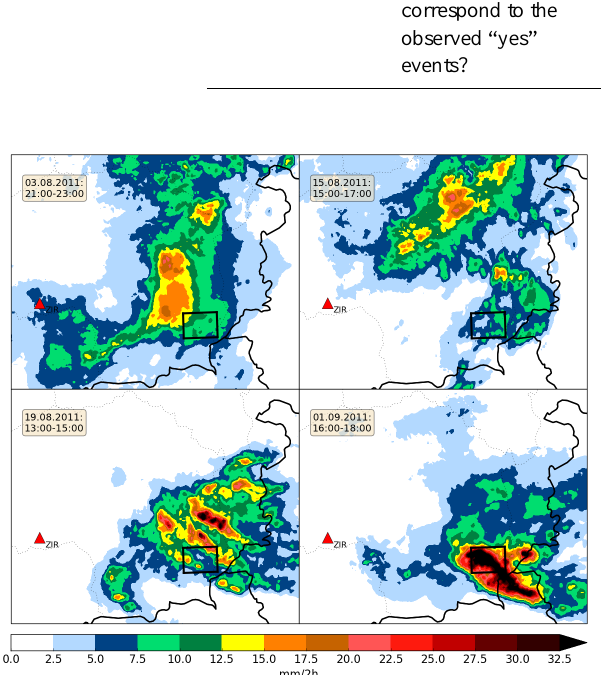
Figure 4. 2h precipitation accumulations of the 5min rapid-INCA analyses on 4 days (top left: 3 August 2011, top right: 15 Au- gust 2011, bottom left: 19 August 2011, bottom right: 1 Septem- ber 2011) in the respective time spans. The WegenerNet region is marked by a small black rectangle, the red triangle represents the radar (Zirbitzkogel) within this zoom.